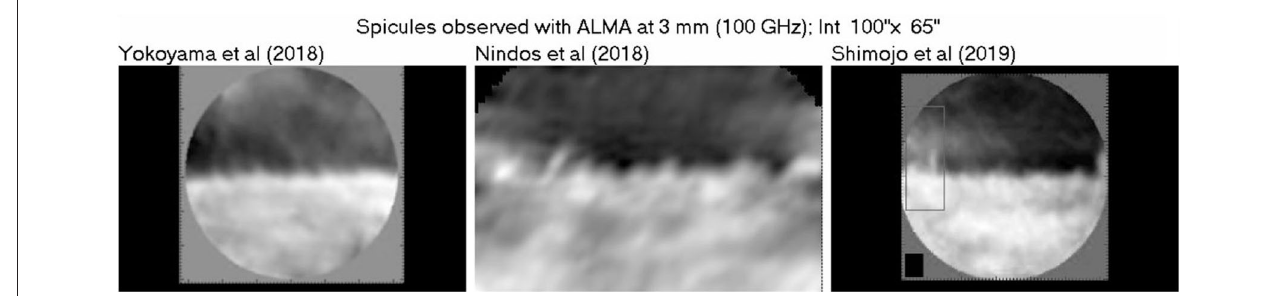
FIGURE 11 | The first ALMA observations of spicules at 100GHz (3mm). Images reprocessed by the author for better visibility. The central image is reproduced with permission © ESO, the others are © AAS, reproduced with permission.